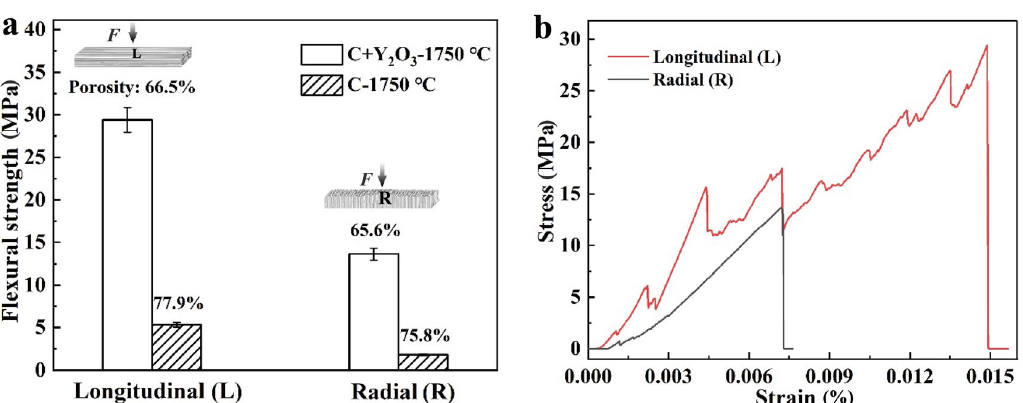
Fig. 5 (a) Anisotropic flexural strength and (b) stress–strain curves of wood-derived bio-Si 3 N 4 ceramics sintered at 1750 ℃ for 4 h.